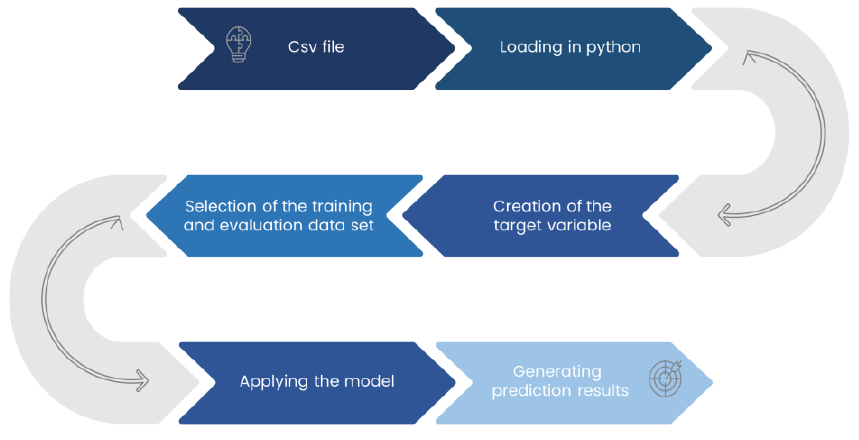
Figure 3. Description of the existing prediction process